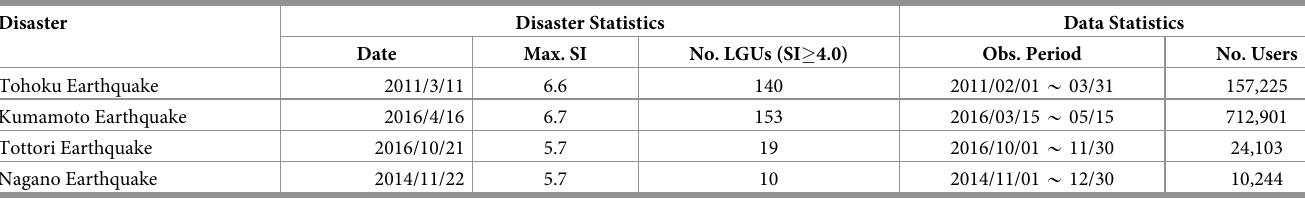
Table 1. Statistics of the four earthquakes and mobile phone data used for analysis.